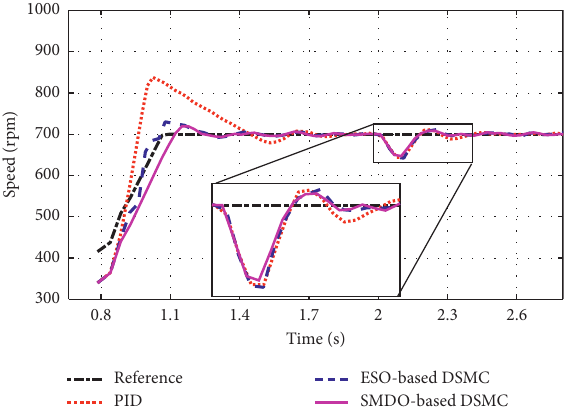
Figure 9: Diesel engine speed response after the controllers start working in the starting process.